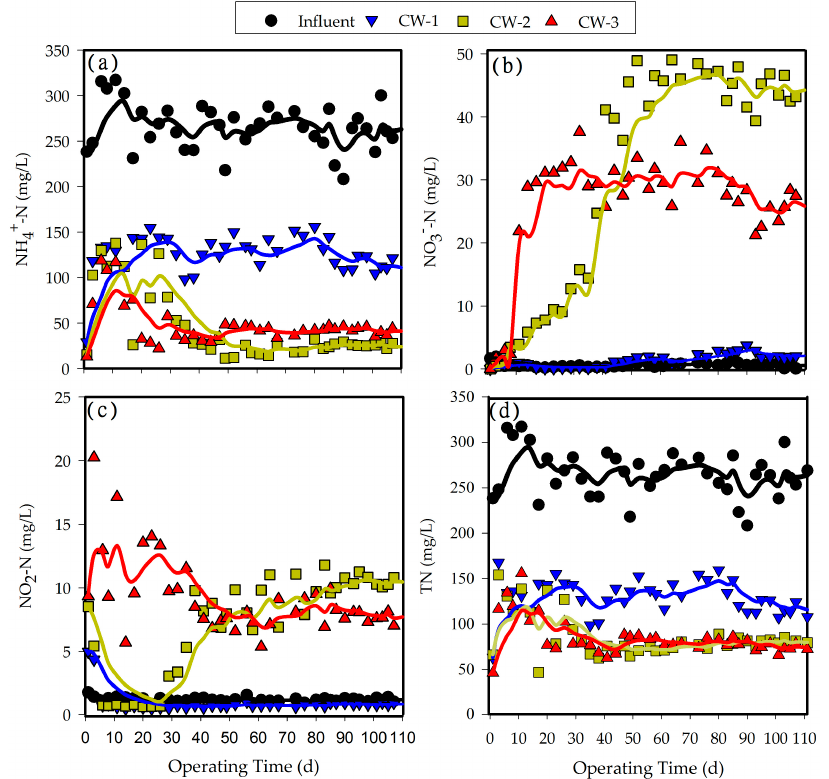
Figure 4. Dynamics of the concentration of nitrogen species in influent and effluent. ( a ) ammonia nitrogen; ( b ) nitrate nitrogen; ( c ) nitrite nitrogen; ( d ) total nitrogen